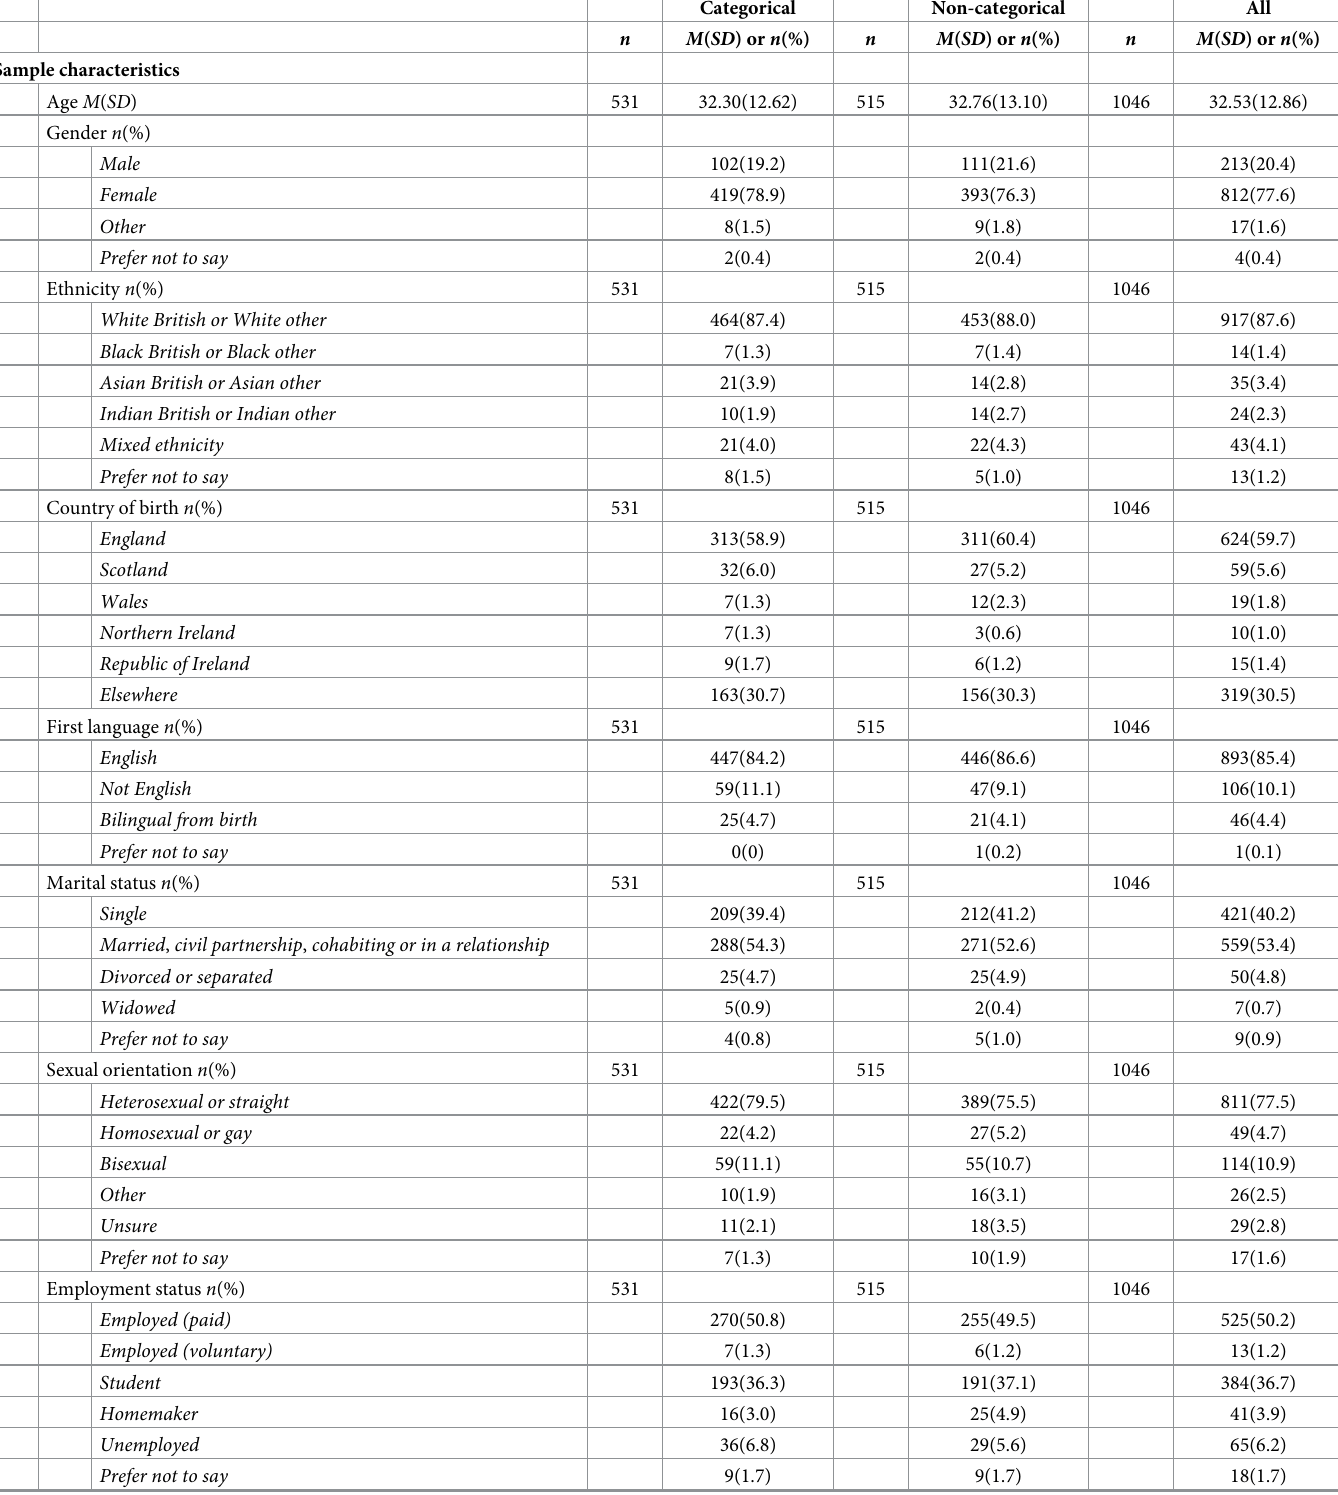
Table 2. Descriptive statistics of the sample characteristics and research data.